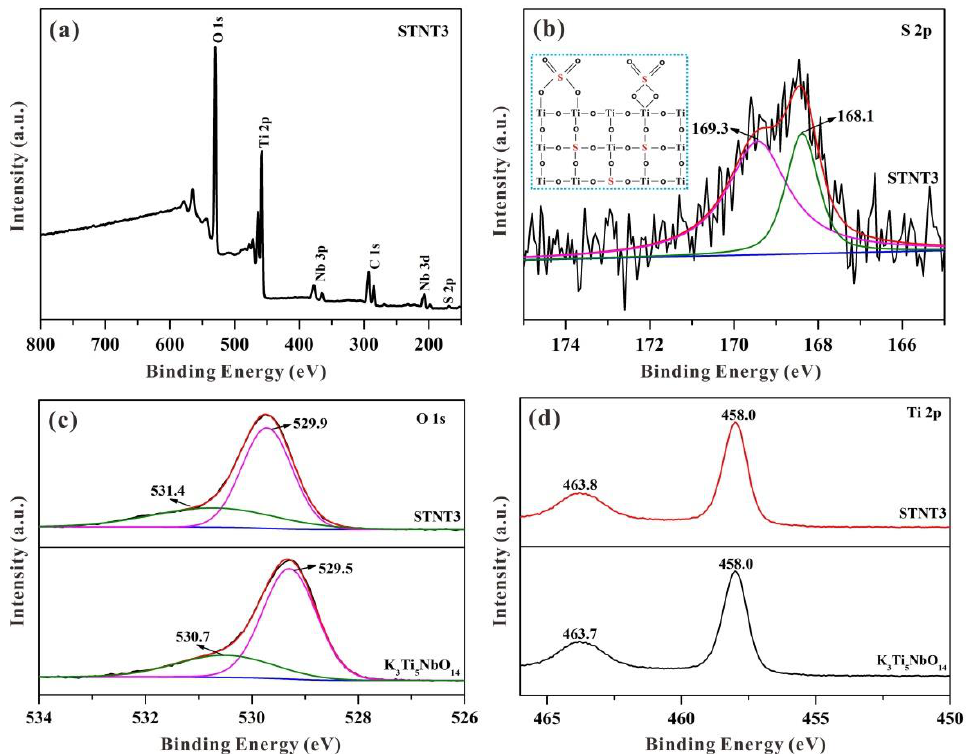
Figure 6. High-resolution XPS spectra for K 3 Ti 5 NbO 14 and STNT3: ( a ) survey, ( b ) S 2p spectrum (inset shows two possible structures of the surface-adsorbed sulfate groups in STNT3), ( c ) O 1s, and ( d ) Ti 2p. Two peaks at 458.0 (Ti 2p 3 / 2 ) and 463.8 eV (Ti 2p 1 / 2 ) in Figure 6d can be clearly visible in the Ti